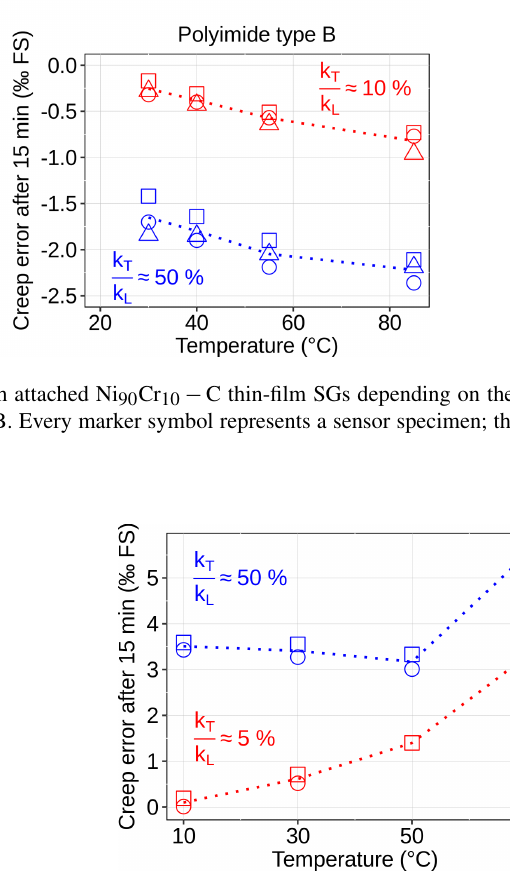
Figure 9. Creep error after 15min of aluminum tension and com- pression force transducers with attached Ni 90 Cr 10 − C thin-film SGs depending on the ratio k T /k L . The SGs are based on polyimide type A. Every marker symbol represents a sensor specimen; the dotted lines connect the average values (not shown